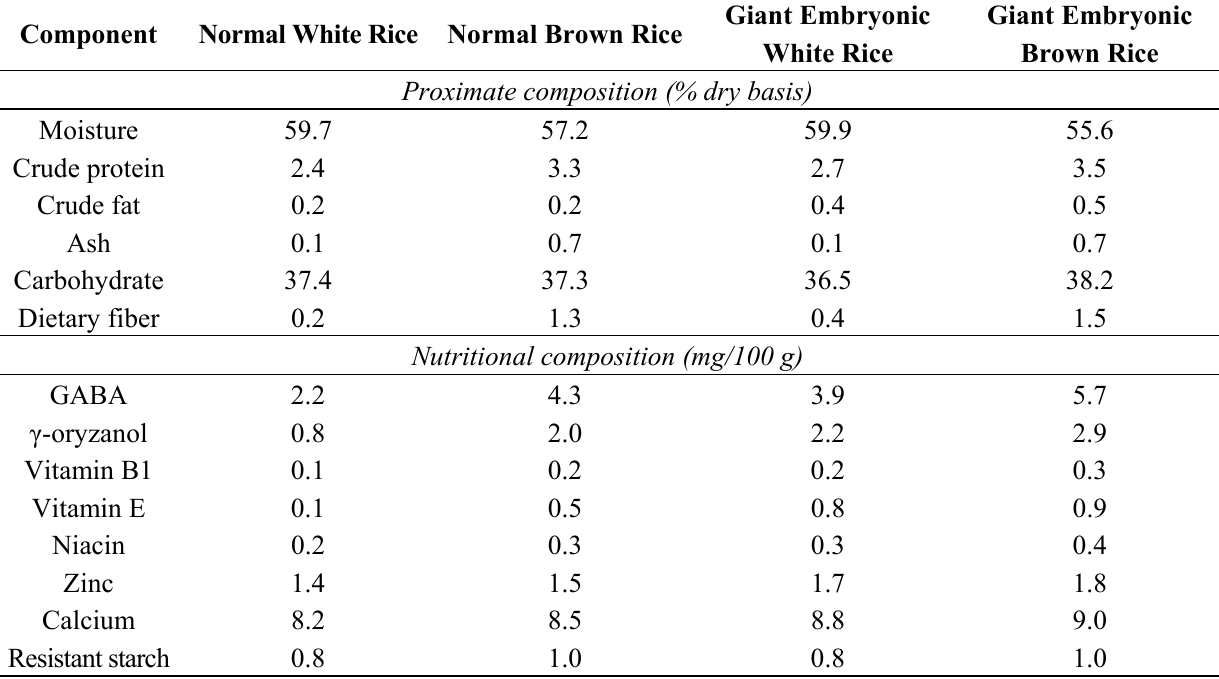
Table 1. Proximate and nutritional compositions of the instant cooked rice samples.